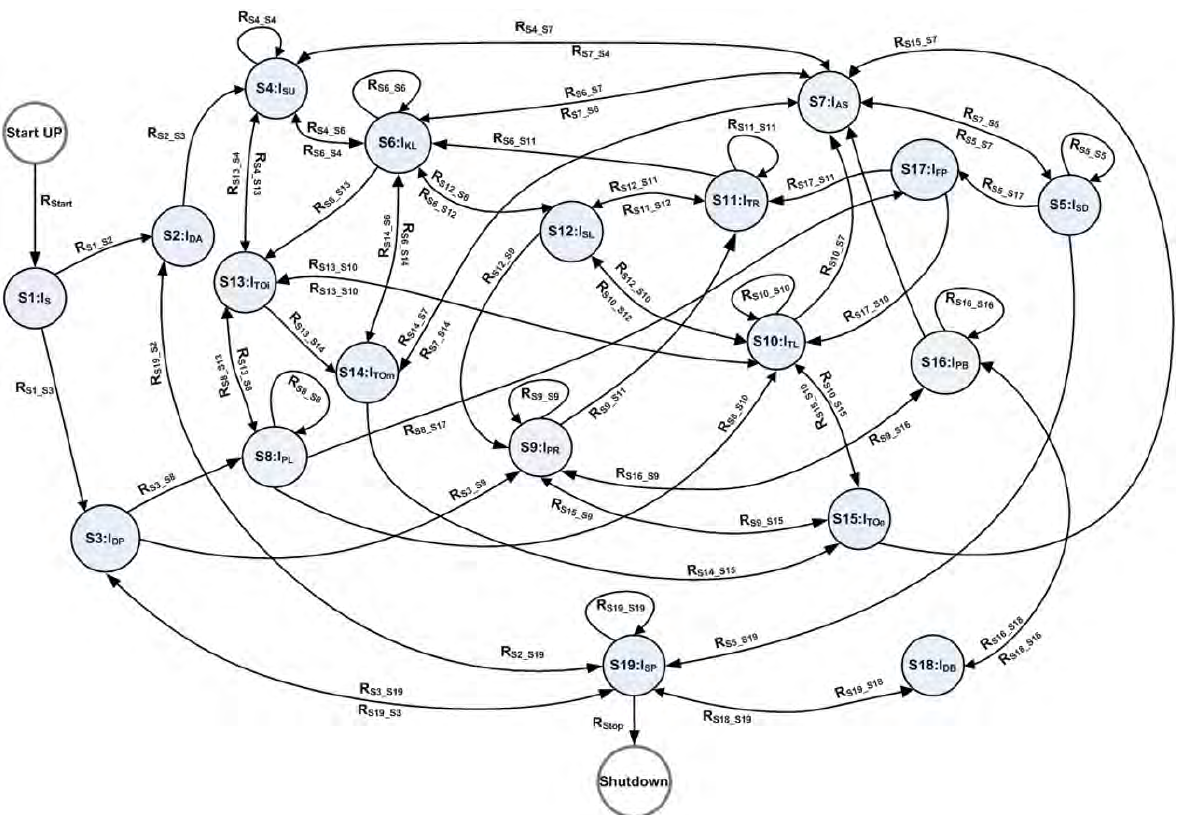
Figure 6. The state diagram describing the driver intention and rules used on each